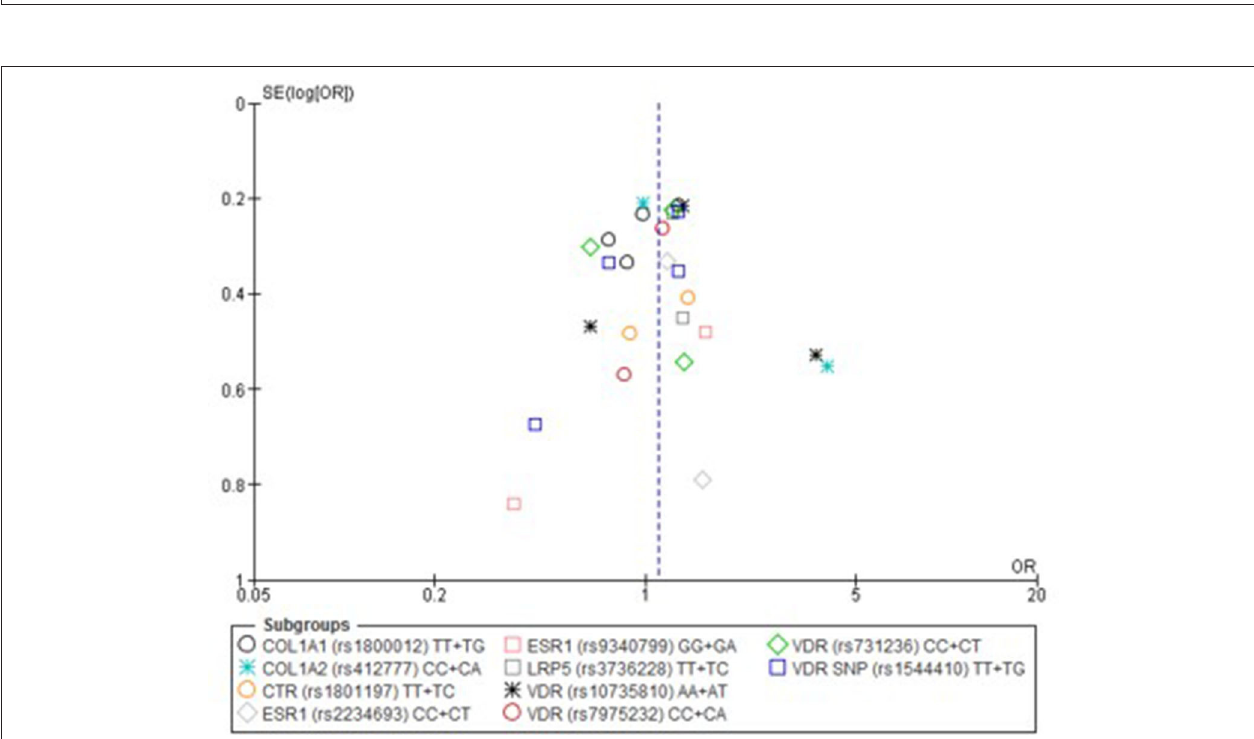
FIGURE 4 | Funnel plot of single nucleotide polymorphisms replicated in studies investigating genetic association with fracture risk in physically active participants using the recessive model.